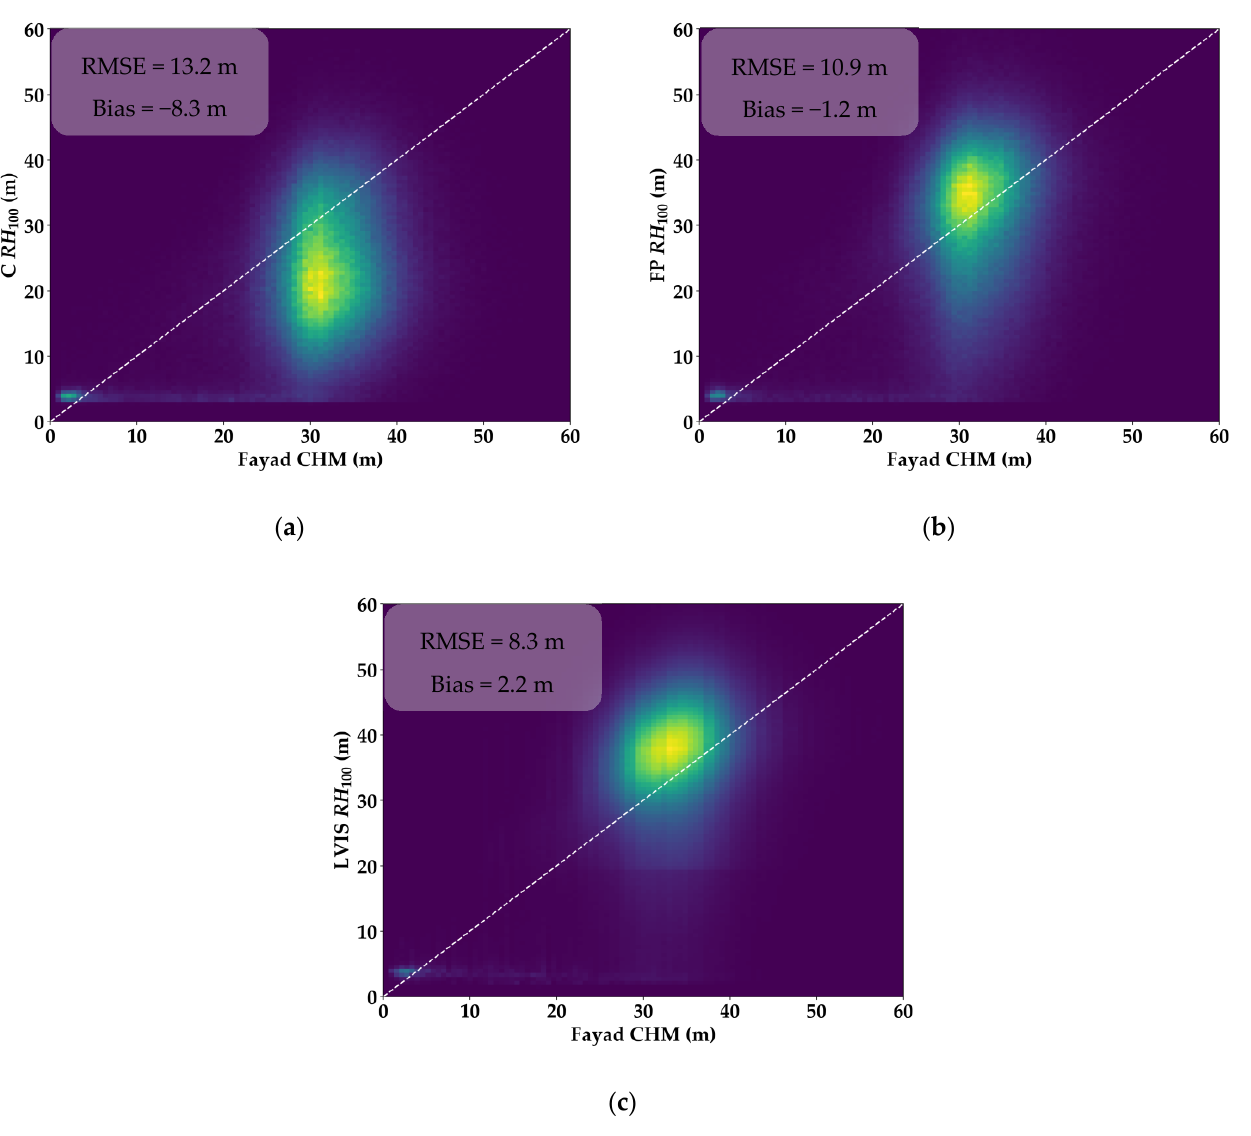
Figure 5. RH 100 estimates from GEDI’s coverage (C RH 100 , a ) and full-power (FP RH 100 , b ) lasers, as well as those from LVIS (LVIS RH 100 , c ) as a function of Fayad CHM.